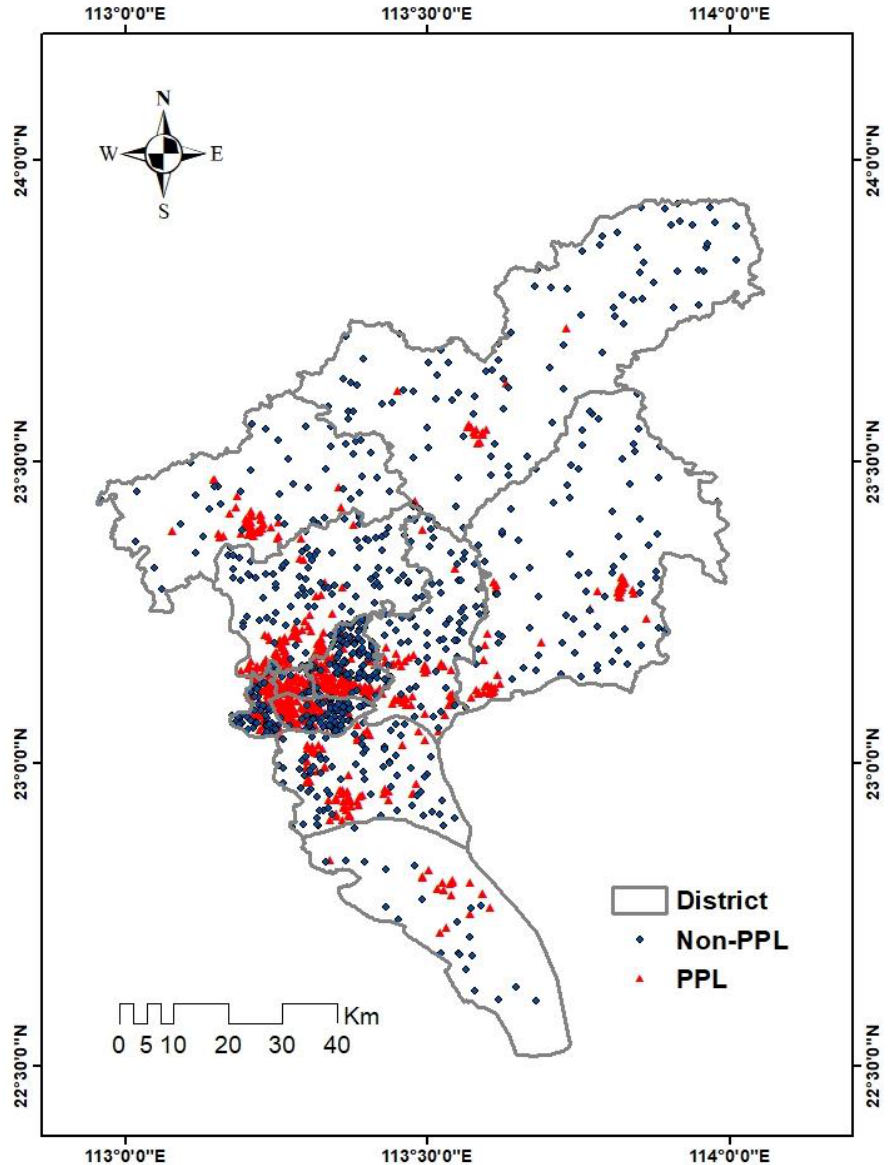
Figure 4. The locations of PPL and non-PPL points.